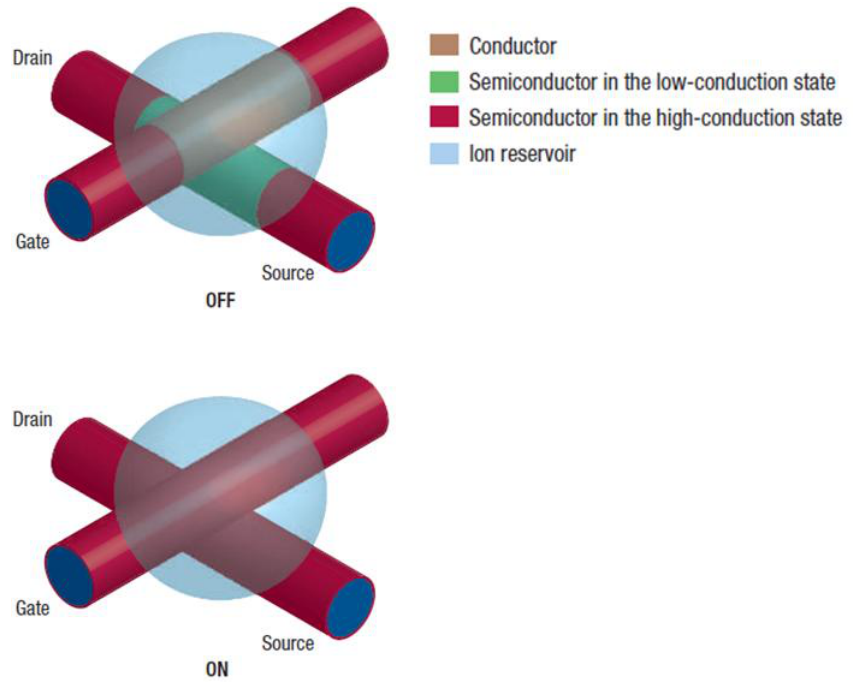
Figure 14. Schematic and working principle of an organic wire electrochemical transistor, formed at a fiber junction connected through an ionic liquid electrolyte. Adapted with permission from [168]. Copyright (2007) by Nature Publishing